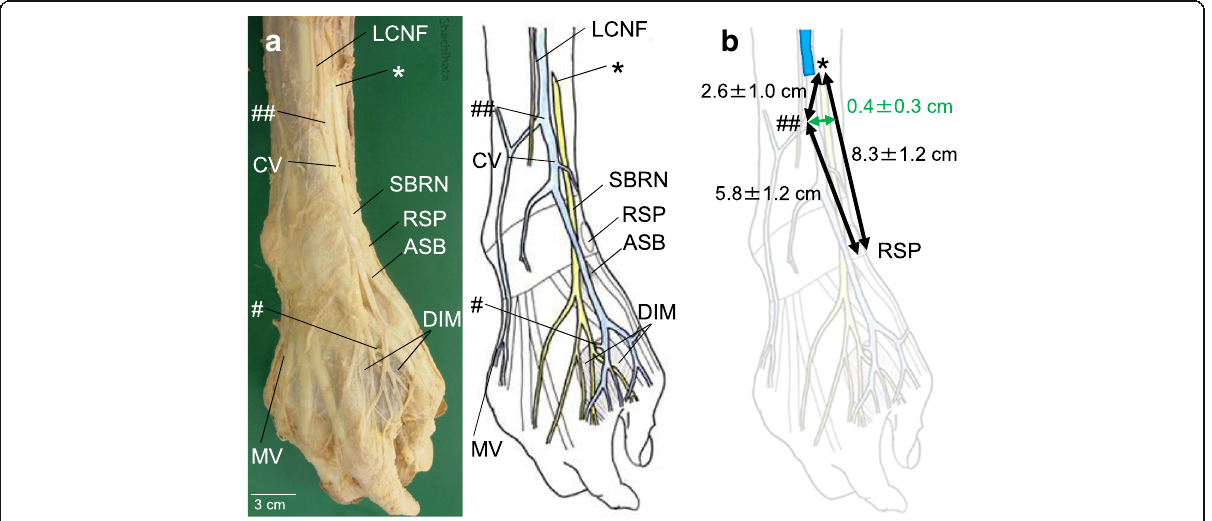
Fig. 1 Gross anatomy of the cephalic vein and superficial branch of the radial nerve (SBRN). a Macroscopic appearance of the forearm. b Distance between radial styloid process (RSP) (* to ##) is shown as mean ± standard deviation. Blue area shows a suggestive safe area for cannulation to the CV. ASB anatomical snuff box, CV cephalic vein, DIM first dorsal interossei muscle, LCNF lateral cutaneous nerve of the forearm, MV metacarpal vein. # Communicating branch of CV to deep palmar vein. ## Confluence of CV and metacarpal vein. *Emergence of